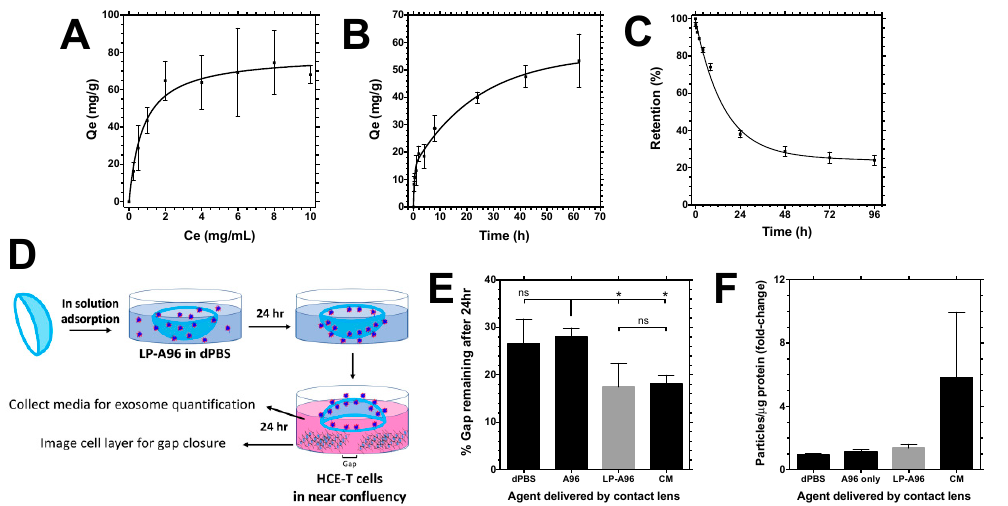
Figure 7. Contact lens-delivered LP-A96 maintains its activity in corneal epithelial cells. ( A ) Concentration-dependent adsorption of LP-A96 to contact lenses over a 24 h period. ( B ) Time-dependent adsorption of 2 mg / mL LP-A96 to contact lenses. ( C ) Time-dependent release of LP-A96 from contact lenses. ( D ) Study design of the contact lens-mediated delivery of LP-A96 to a scratch (gap) generated corneal epithelial cell monolayer. ( E ) Gap closure activity of HCE-T cells incubated with contact lenses loaded with di ff erent agents. ( F ) After gap closure activity measurement, exosomes were purified from culture media and quantified using nanoparticle tracking analyzer. ( F ) Exosome abundance in the culture media after 24 h period. A one-way ANOVA followed by multiple comparisons was used for statistical comparison. CM indicates complete media. * p < 0.05, ns: non-significant. Mean ± SD. Table 2. Adsorption and release kinetics of LP-A96 in Proclear Compatibles TM contact lenses. Concentration- Time-Dependent Dependent Time-DependentRelease Parameters Parameters Adsorption (Mean Parameters Adsorption (Mean (Mean (95% CI)) Parameters (95% CI)) (95% CI)) Q m (mg / g) 78.6